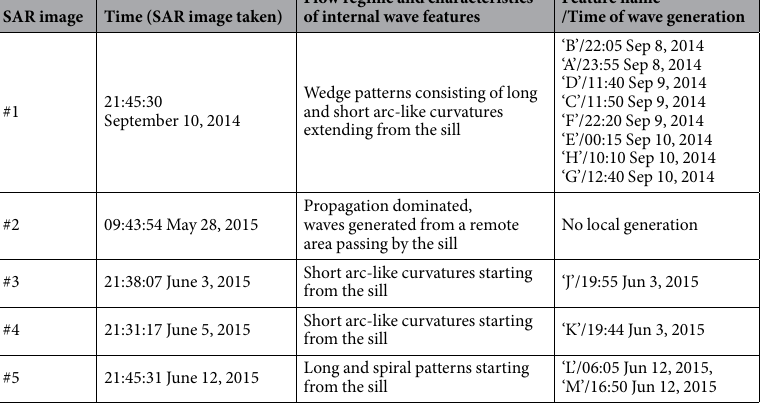
SAR image Time (SAR image taken)